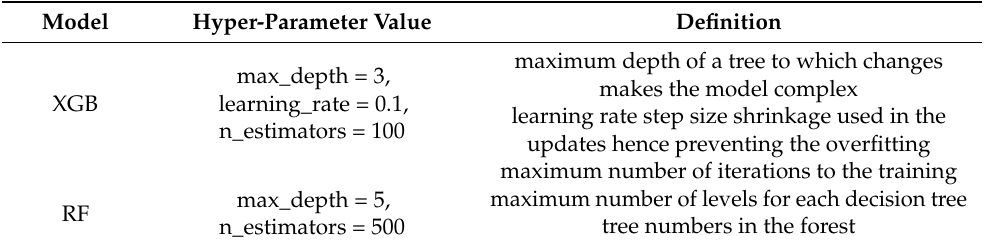
Table 3. Classification hyper-parameters used for XGB and RF algorithm.